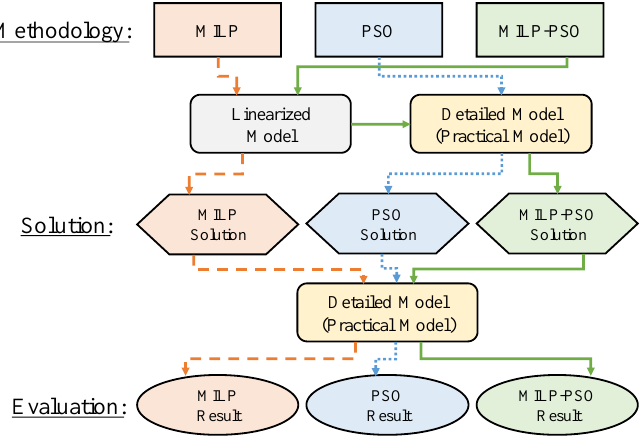
Figure 6. Solution evaluation methodology among algorithms.